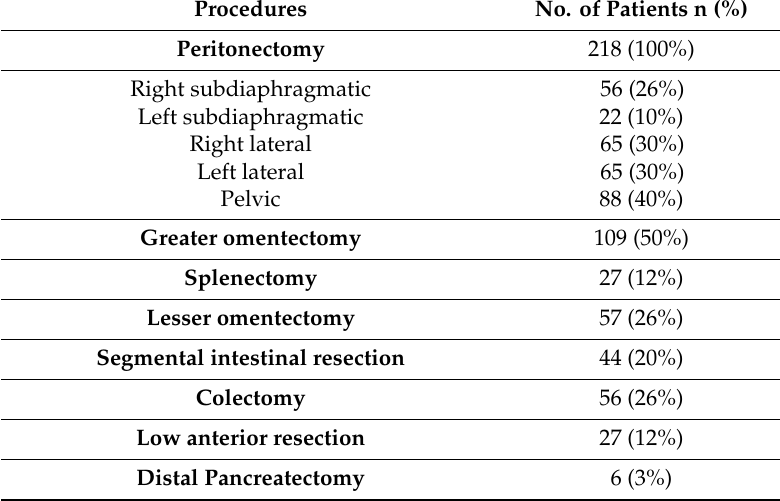
Table 3. Spectrum of CRS + HIPEC procedures performed in the